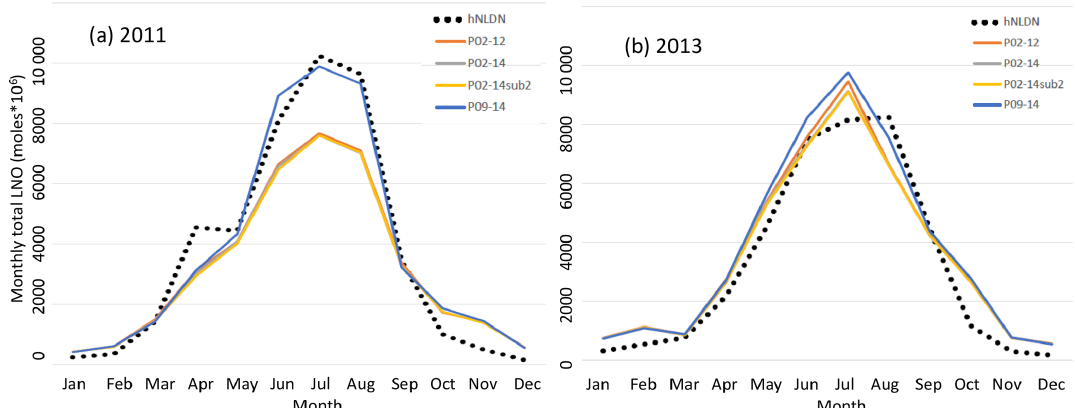
Figure 7. Total monthly column LNO over the model domain using parameters derived from different time periods for (a) 2011 and (b) 2013. hNLDN: LNO is produced by the hourly NLDN lightning flashes, P02-12: parameters derived using data from 2002 to 2012, P02-14: parameters derived using data from 2002 to 2014, P02-14sb2: parameters derived using data from 2002 to 2014 excluding 2011 and 2013, and P09-14: parameters derived using data from 2009 to 2014.